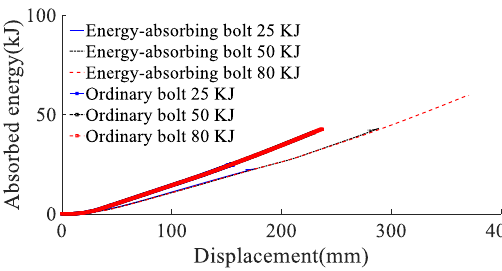
Figure 8. Anchor force – time curve: ( a ) impact energy 25 kJ; ( b ) impact energy 50 kJ; ( c ) impact en- ergy 80 kJ.